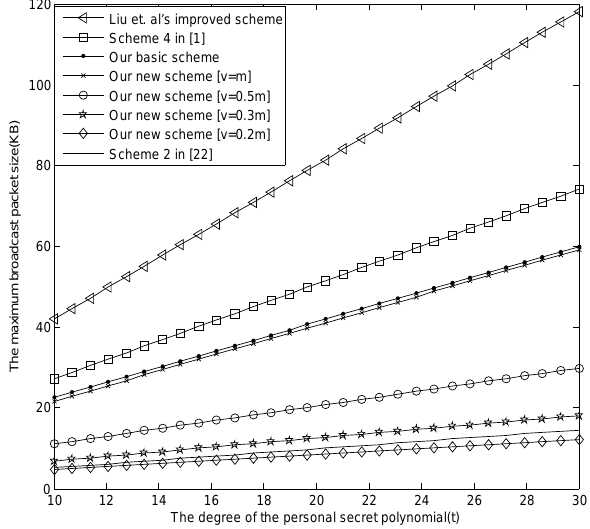
Figure 1. The first comparison of the broadcast